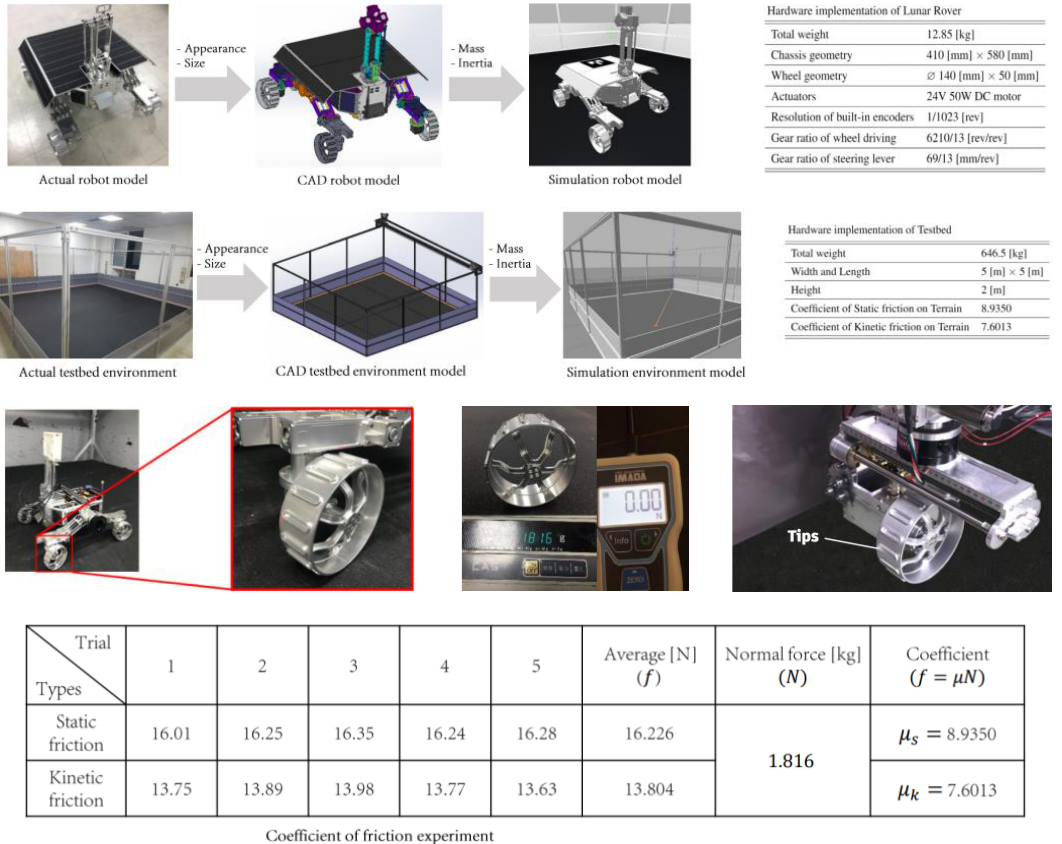
Figure 16. Images of the full-scale robot and testbed environment, and simulated models reflecting their actual physical characteristics.